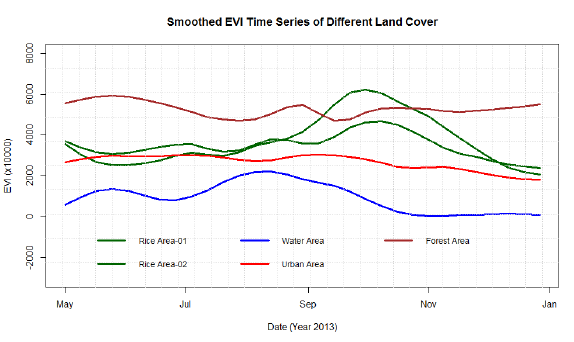
Figure 4: EVI Time series graphs of different land